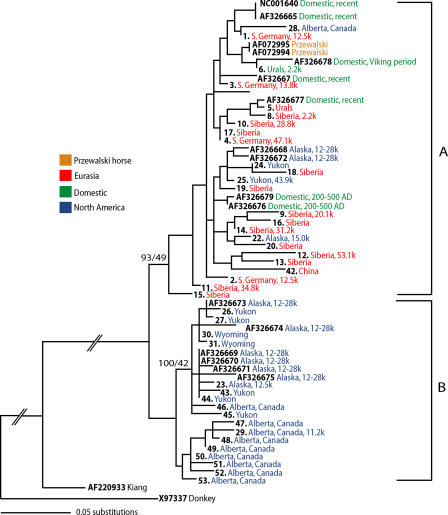
Maximum Likelihood Phylogenetic Tree of Recent, Historic, and Pleistocene Caballine Horses Based on 364 bp of the Mitochondrial Control Region (HVR1)Posterior probabilities/bootstrap values are presented above or beside the main nodes only if either is > 50%. Labels of prehistoric specimens are followed by their age, if available, in thousands of years (k).